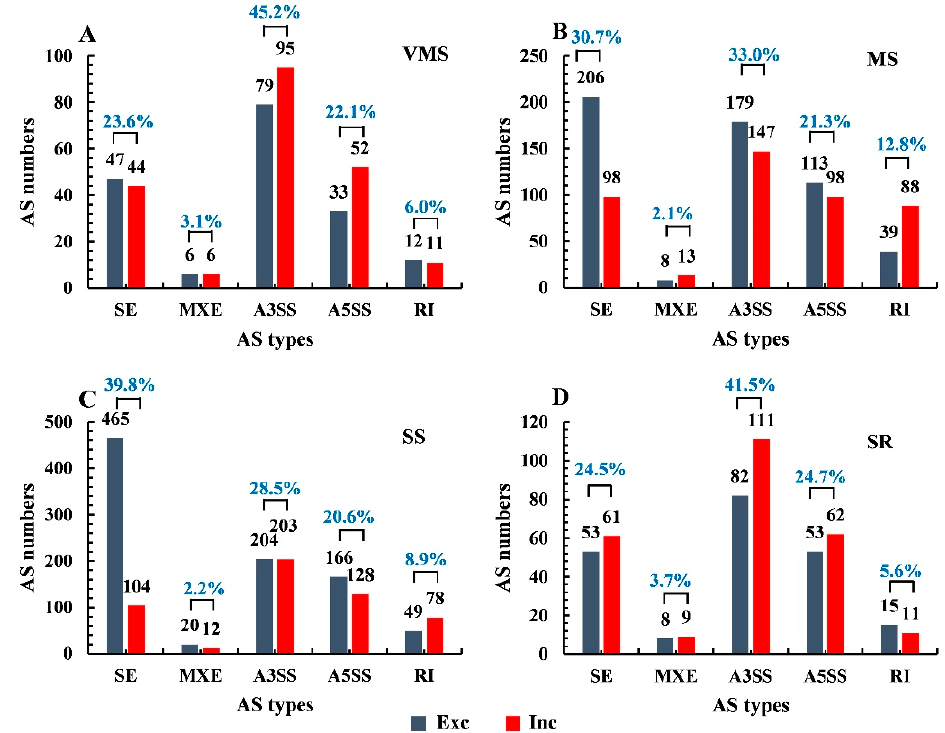
Figure 2. Comparison of the number and proportions of di ff erential AS events under various drought conditions. ( A ) Under VMS condition, ( B ) under MS condition, ( C ) under SS condition, and ( D ) under SR condition. Exclusion is shown in blue, and inclusion is shown in red. The y -axis shows the number of AS events. The x -axis shows the types of AS.